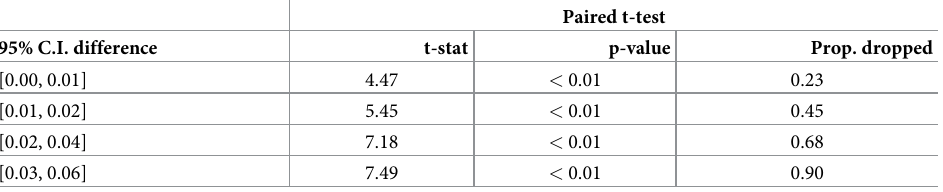
Table 6. Effects of missing data on MAE on 138 trees. The null hypothesis for the paired t-test is MAE(with X% annotations randomly dropped)—MAE(baseline) = 0. As more annotations are randomly removed from the tree, mean absolute error increases